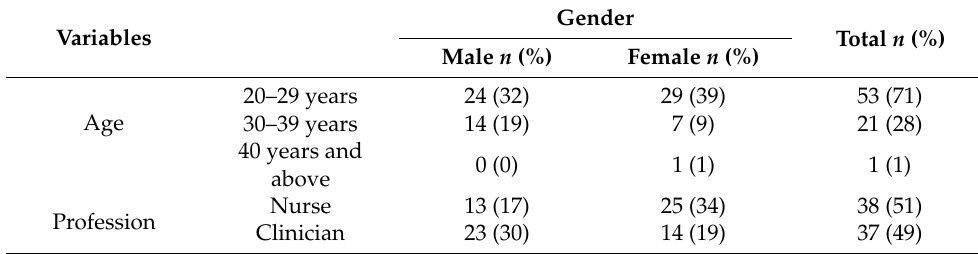
Table 1. Demographic factors of the study